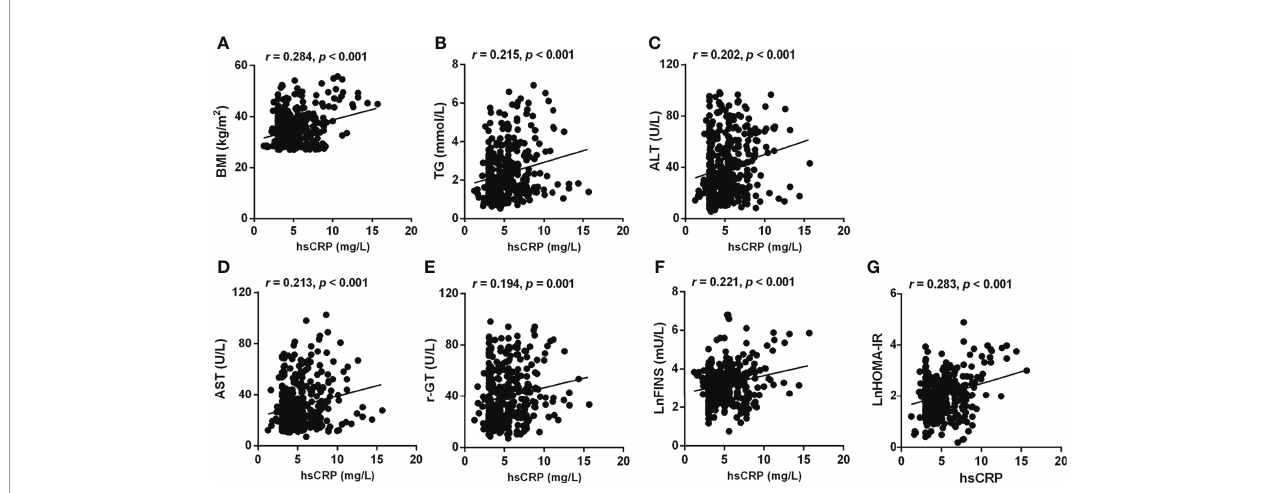
FIGURE 3 | Correlations between hsCRP and other metabolic risk factors related to MAFLD, steatosis, and fi brosis. Serum hsCRP levels were positively associated with BMI (A) , TG (B) , ALT (C) , AST (D) , g -GT (E) , LnFINS (F) , and LnHOMA-IR (G) . Non-normally distributed data were log-transformed before analysis. P -values < 0.05 were accepted as statistically signi fi cant.